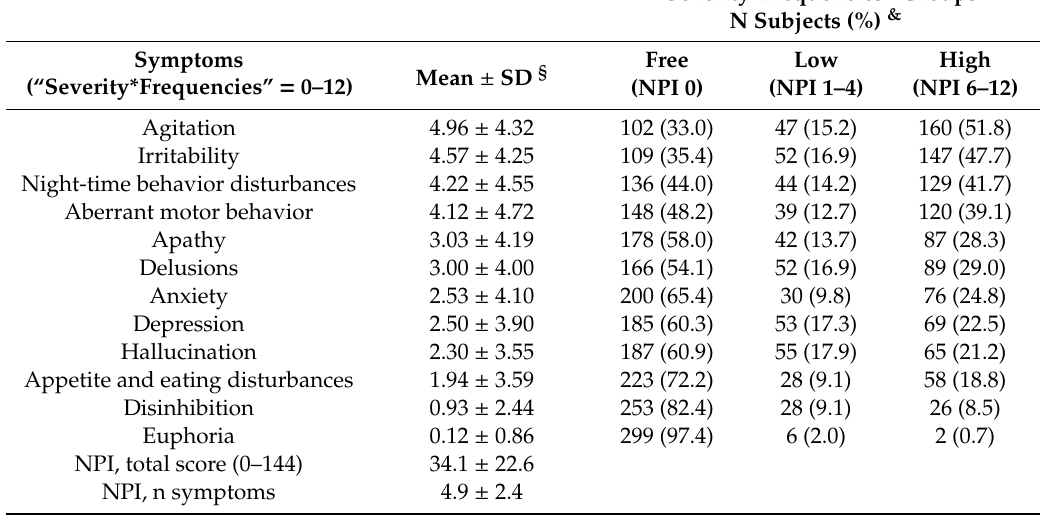
Table 3. Clinical distributions of single Behavioral and Psychological Symptoms of Dementia (BPSD) in our Italian Alzheimer’s Disease